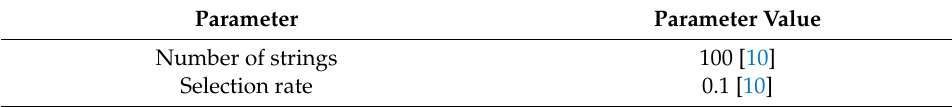
Table 5. List of ES parameters used in Logic Phase.